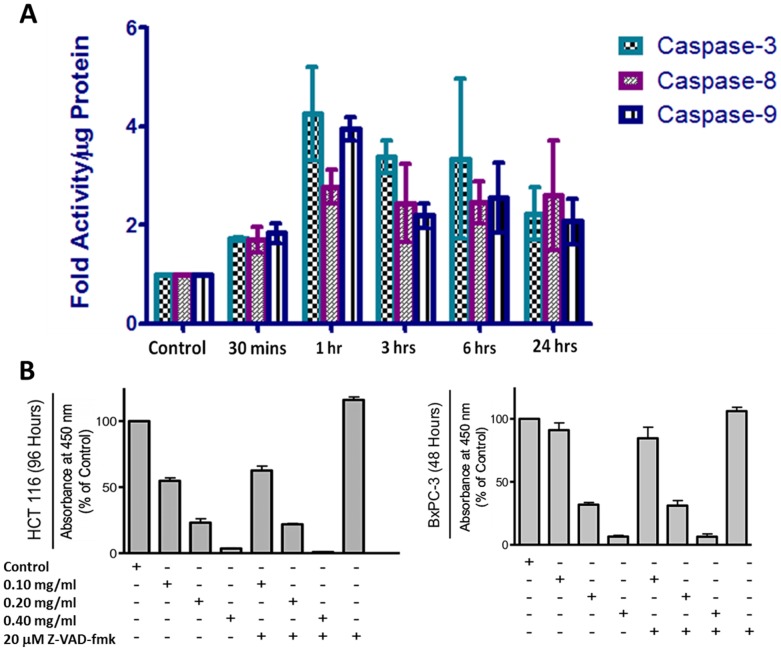
Long Pepper Extact (PLX) Activates the Extrinsic & Intrinsic Pathways of Apoptosis.Following treatment with 0.10 mg/ml PLX, at indicated time points, BxPc-3 cells were collected, washed and incubated with lysis buffer to obtain cell lysate. The cell lysate was incubated with caspase substrates, specific to each caspase (3, 8 and 9) and incubated for an hour. Fluorescence readings were obtained using a spectrofluorometer. An average of 6 readings per well and a minimum of three wells were run per experiment. The results here are reported as activity per µg of protein (in fold) and the average of three independent experiments is shown. (B) The reduction in viability was caspase independent, as a pan-caspase inhibitor, Z-VAD-fmk could not prevent the loss of viability induced by PLX treatment in colon and pancreatic cancer cells. Absorbance was read at 450 nm and expressed as a percent of the control. Values are expressed as mean ± SD from quadruplicates of 3 independent experiments. **P<0.0001.